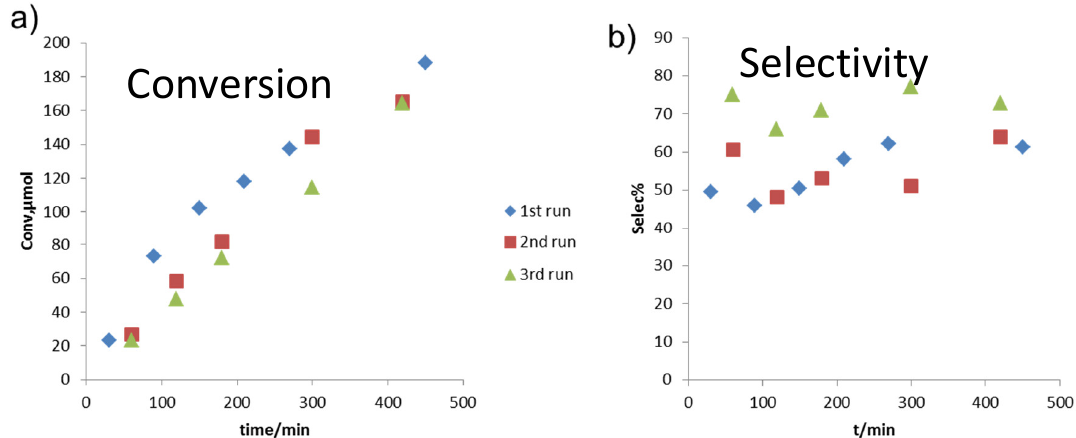
Figure 7. Recyclability study with fructose as feedstock. Reaction conditions: solvent of THF/water 9:1 ( v / v ), reaction temperature of 160 °C, 2 wt % fructose, 5 mg each of Lewis and Brønsted catalyst/g of reaction media.